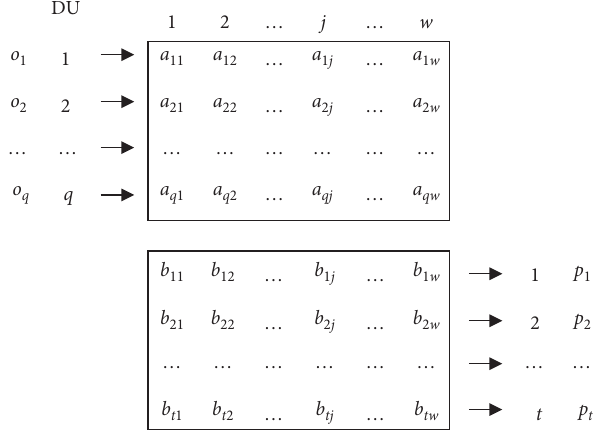
Figure 5: Input-output of